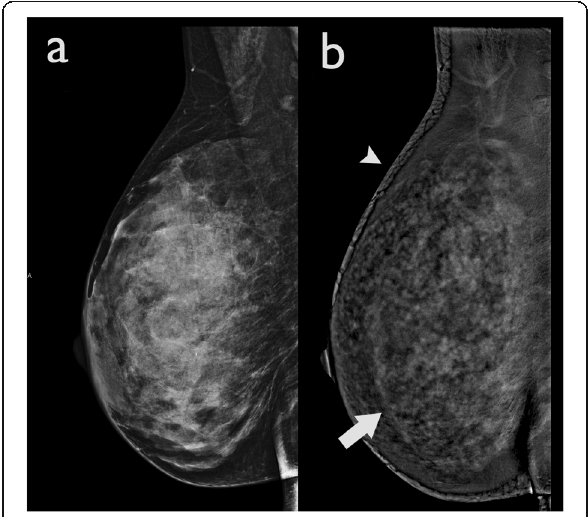
Fig. 10 Halo artefact in a 52-year-old woman. a The LE CEDM image demonstrates a dense breast with no show focal alterations, and ( b ) the recombined image presents an apparent “ breast-within-a-breast ” artefact (arrow). The skin artefact that is observed in the right breast (arrowhead) is caused by detector saturation in the skin region due to a high detector signal